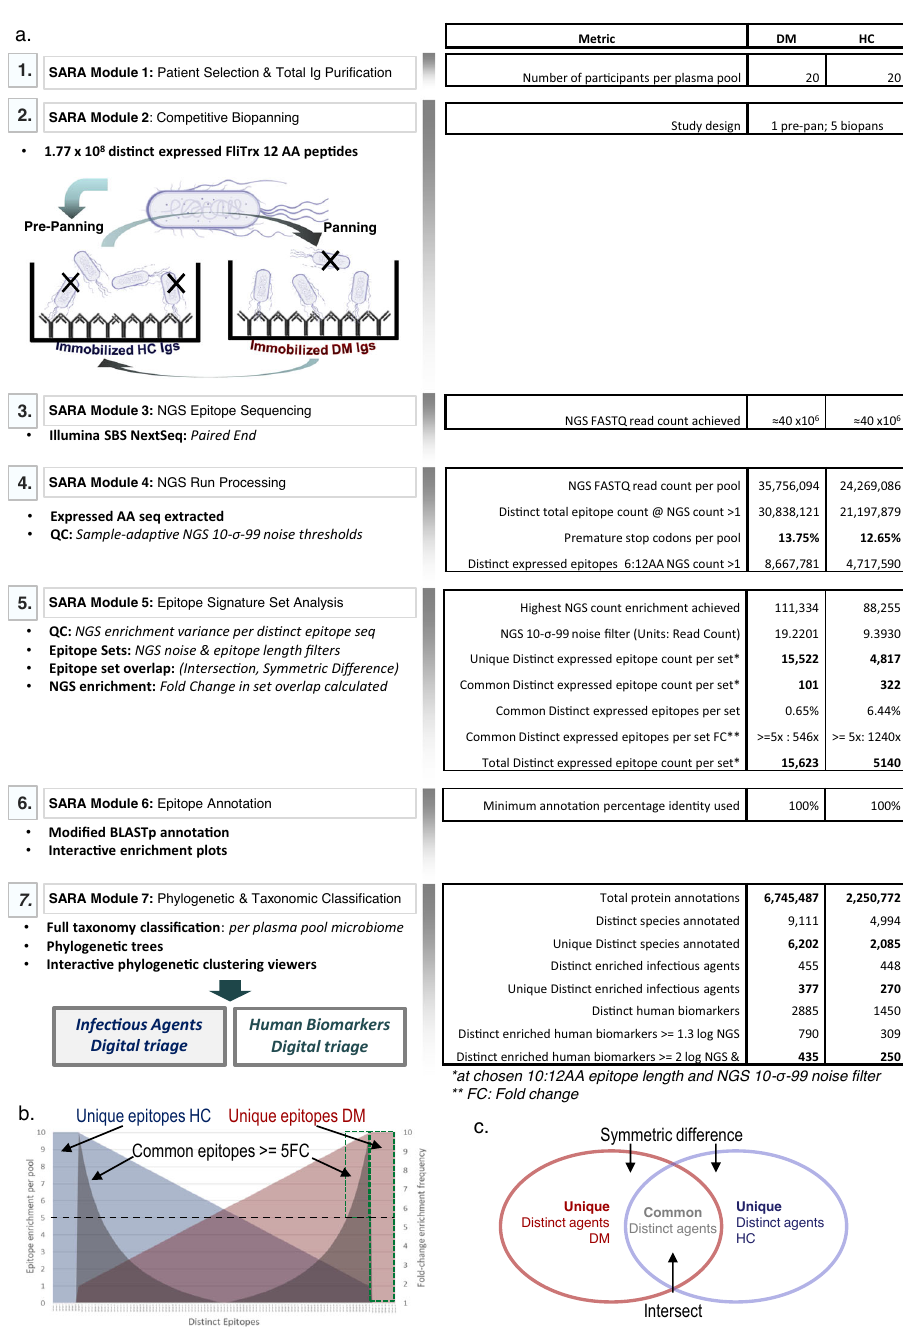
Fig. 1 The serum antibody repertoire analysis (SARA) pipeline employed for plasma samples of dermatomyositis patients. a SARA pipeline modules and metrics from this investigation. Module 1: Patient Selection and Total Ig Puri fi cation. Module 2: Competitive Biopanning. Pre-planned clones which bind immobilised healthy control (HC) Igs were discarded. Unbound clones passed immediately across immobilised dermatomyositis (DM) pool Igs. Retained clones contain amino acid (AA) epitope sequences of interest. Module 3: Next-generation sequencing (NGS) Epitope Sequencing. Biopanned-enriched epitopes were DNA sequenced (custom Illumina NextSeq process). Module 4: NGS Run Processing. Expressed peptide DNA variance regions were extracted and NGS noise removed (10- σ -99 threshold). Module 5: Epitope Signature Set Analysis. Epitope sequence frequency per AA length was determined. Distinct epitope set analysis determined unique distinct epitope pools within DM and HC. Distinct epitopes common to both cohorts were further segregated by fi vefold NGS enrichment thresholds. Module 6: Epitope Annotation. Our modi fi ed BLASTp process annotated epitope sequences to every known protein. Module 7: Phylogenetic and Taxonomic Classi fi cation. Annotated Organisms were anchored by taxonomic classi fi cations to contextualise the plasma pool microbial pro fi les in DM and HC cohorts. b Example schematic of enriched Distinct epitopes (blue: HC pool; Red: DM pool, grey: fold-change). Unique Distinct sets populate from epitopes exclusively in one pool ( fl anking blue/red areas; no fold-change overlay). Common Distinct sets populate from an epitope common to both pools with ≥ fi vefold enrichment differential (black dotted line). Green dotted boxes thus represent the sum of Unique Distinct and Common Distinct epitope sets from our DM analysis (not to scale). c Venn diagram of Unique Distinct (symmetric difference) and Common Distinct (intersect) infectious